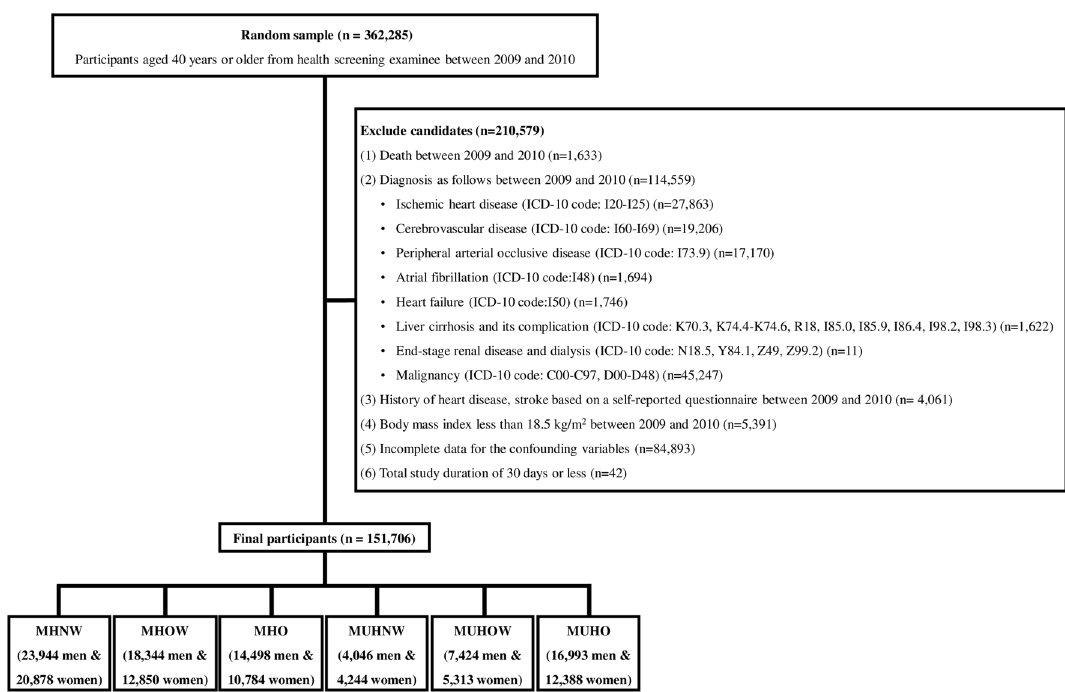
Figure 1. Flow chart of inclusion and exclusion criteria of